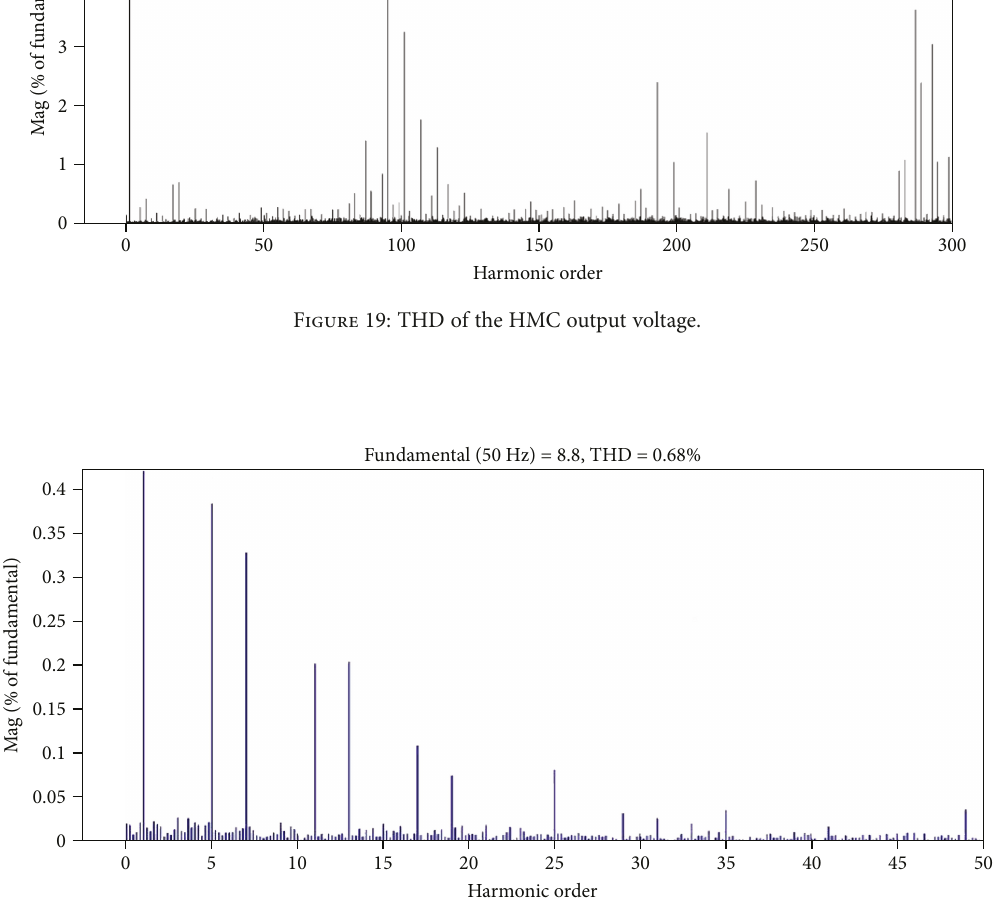
Figure 20: THD of the HMC output